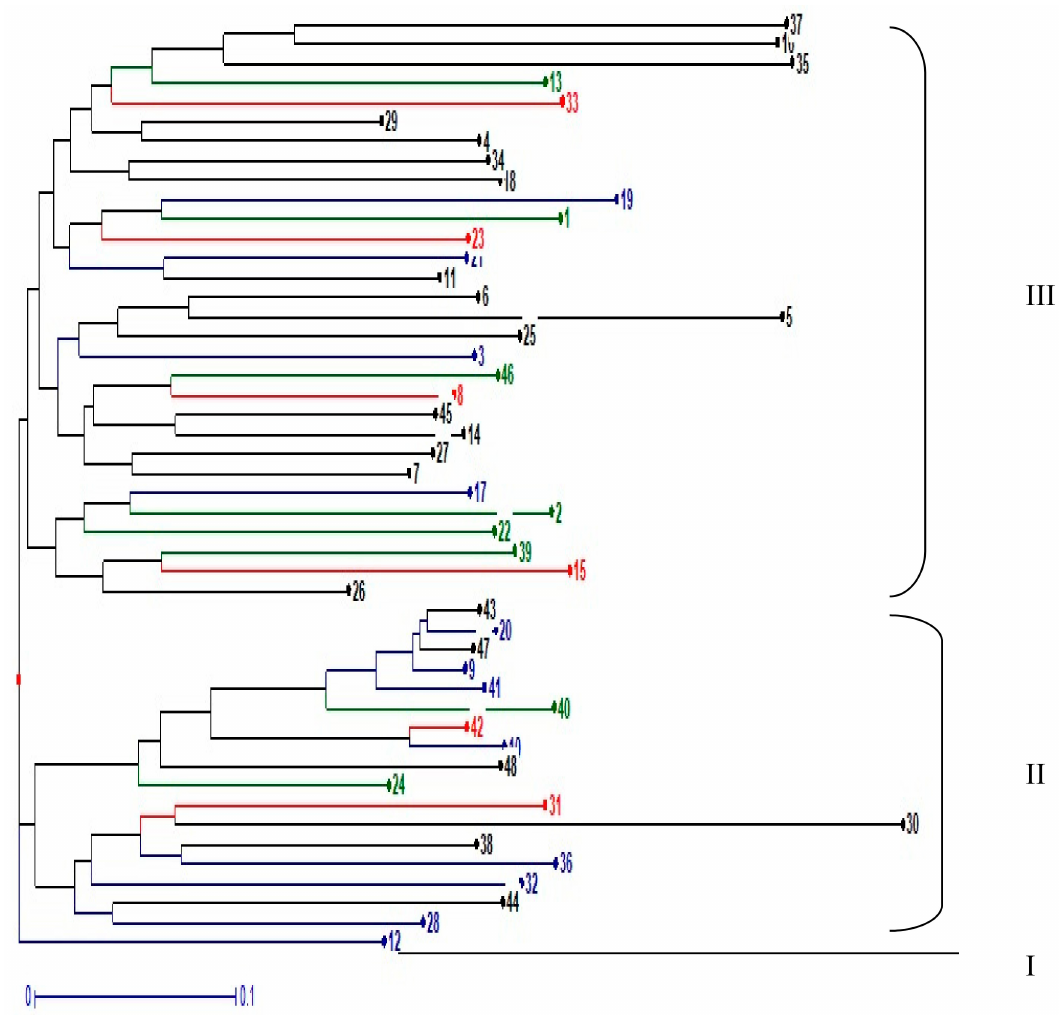
Figure 2. Dendrogram showing genetic relationship among 48 pigeonpea genotypes tested using 35 SSR markers. Accessions with the same colour share the same source of